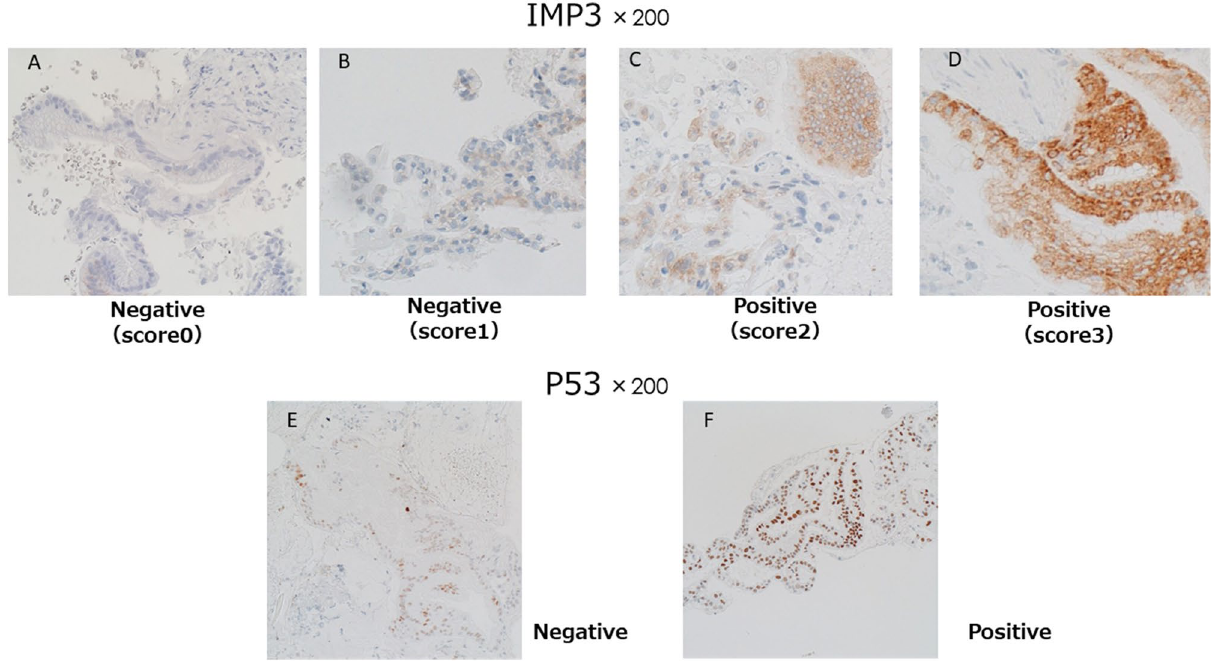
Figure 1. Representative positive and negative cases for IMP3 and TP53. Immunohistochemical IMP3 expression revealed negative (score 0) staining in ( A ), negative (score 1+) staining in ( B ), moderate (score 2+) staining in ( C ), strong (score 3+) staining in ( D ). Immunohistochemical P53 expression revealed negative staining in ( E ) and positive staining in ( F